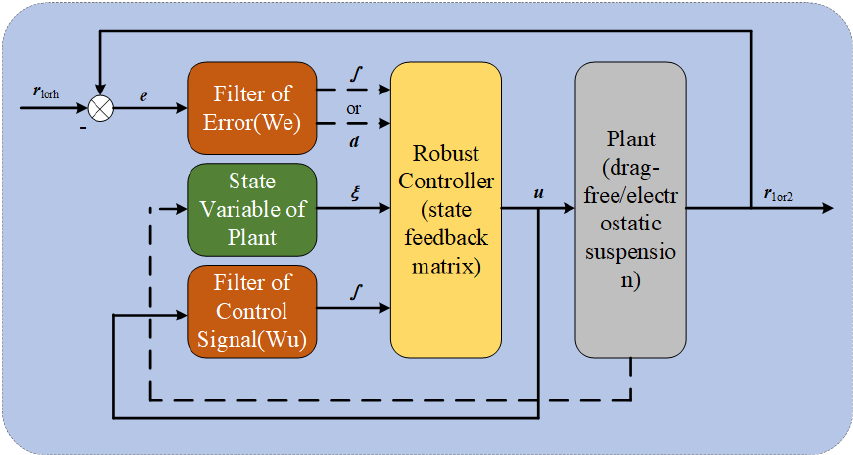
Figure 6. Block diagram of control